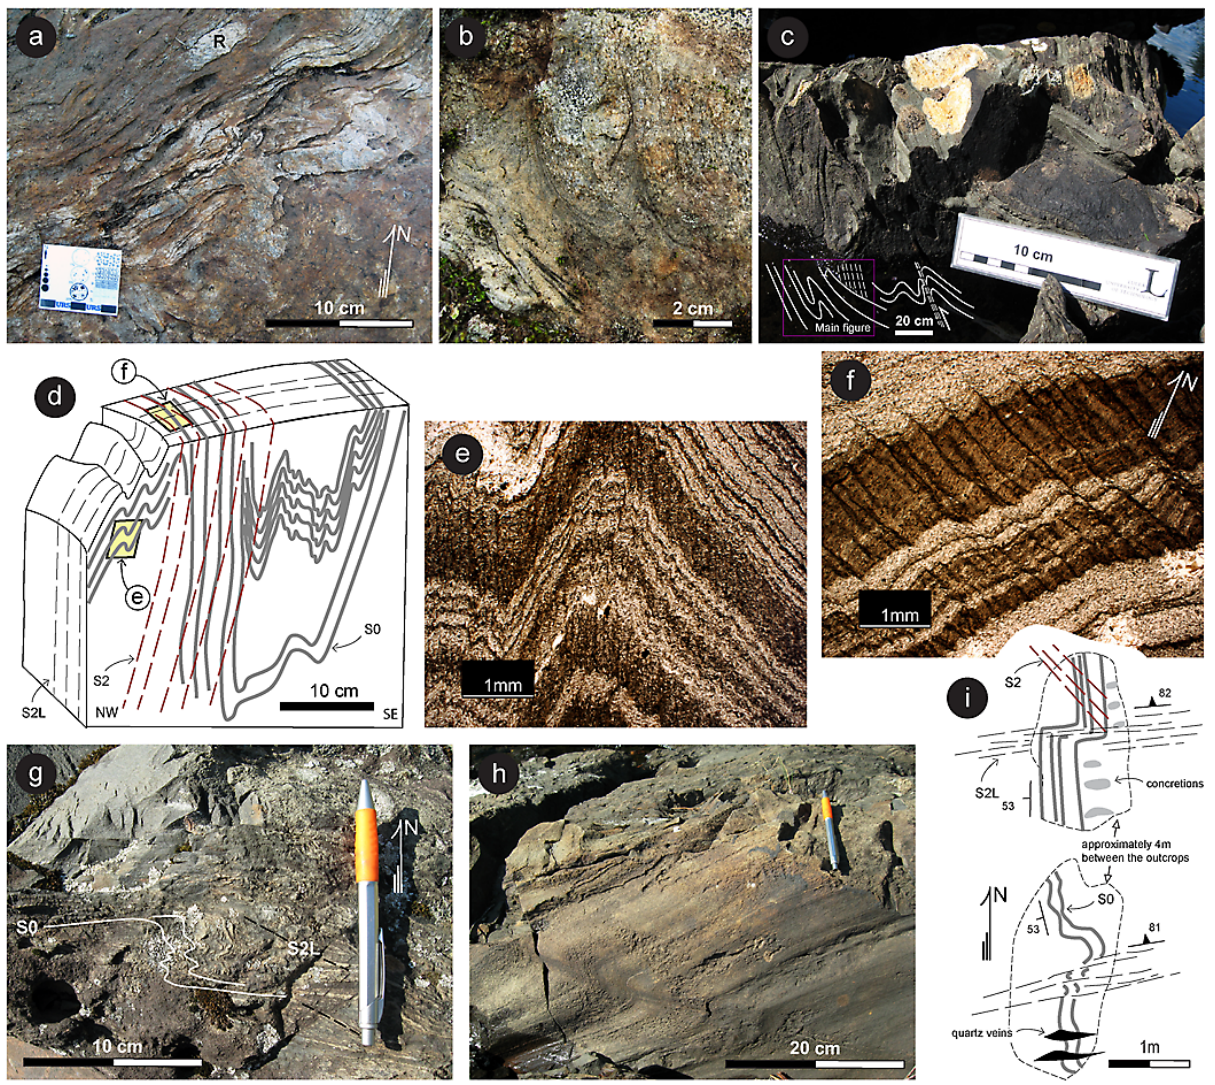
Fig. 7. Folds and fabrics within the metasedimentary (a–i) and metavolcanic (j–n) rocks. Distinction between the structures of successive generations is elaborated in Sect. 4.3.2. However, the final labels for the structures are used in the maps to allow better readability. (a) Contact between the Skellefte Group felsic volcanic rock (bottom) and the Vargfors Group metasedimentary rocks (top). Notice the volcanic rip-off clast (R) in the metasedimentary rock. (b) Load casts indicating stratigraphic younging upwards in metasedimentary rocks with sub- horizontal bedding surfaces cross-cut by sub-vertical S2 foliation. Vertical section, view towards NW. (c) Cylindrical F2 folds overturned towards south. The inset illustrates the parallel attitude of local reverse shear zones and the S2 foliation. Vertical section, view towards WNW. (d) Field sketch of upright, ductile F2 folds overprinted by spaced S2L foliation. (e) S2 foliation developed along the axial surface of an upright F2 fold, see (d) for location. Vertical section, view towards NE. (f) Asymmetric, spaced S2L crenulation cleavage deforms bedding and the sub-parallel S2 foliation. (g) Asymmetric z-shaped F2-folds overprinted by S2L crenulation cleavage in a micaceous domain of the metasedimentary rocks. (h) S-shaped F2L-folds developed in a sandy unit of a metasedimentary succession. Vertical section, view towards NNW. (i) Stratified metasedimentary rocks displaying a weak oblique S2 foliation, subsequently overprinted by distinct D2L-shear zones, associated with the development of S2L shear foliation, transposition of concretions, and syntectonic quartz veining. (j) D2l-crenulations overprinting isoclinal F2 folds. (k) Composite crenulation and solution cleavage surfaces deforming altered metavolcanic rocks close to the western contact of the Viterliden intrusion. Microphotograph. (l) Chlorite porphyroblasts with an internal (Sc) foliation occurring at a high angle towards the external main foliation (S2). Microphotograph; approximately horizontal section, north upwards. (m) Isoclinal F2-folds deforming the weak older foliation in altered metavolcanic rocks, both overprinted by open NW–SE striking D2L crenulations. Microphotograph, sub-horizontal view, north upwards. Width of view 11mm. (n) Close-up of (m) displaying folding of the oldest generation of foliation (Sc) around the F2 fold hinge. Width of view approximately